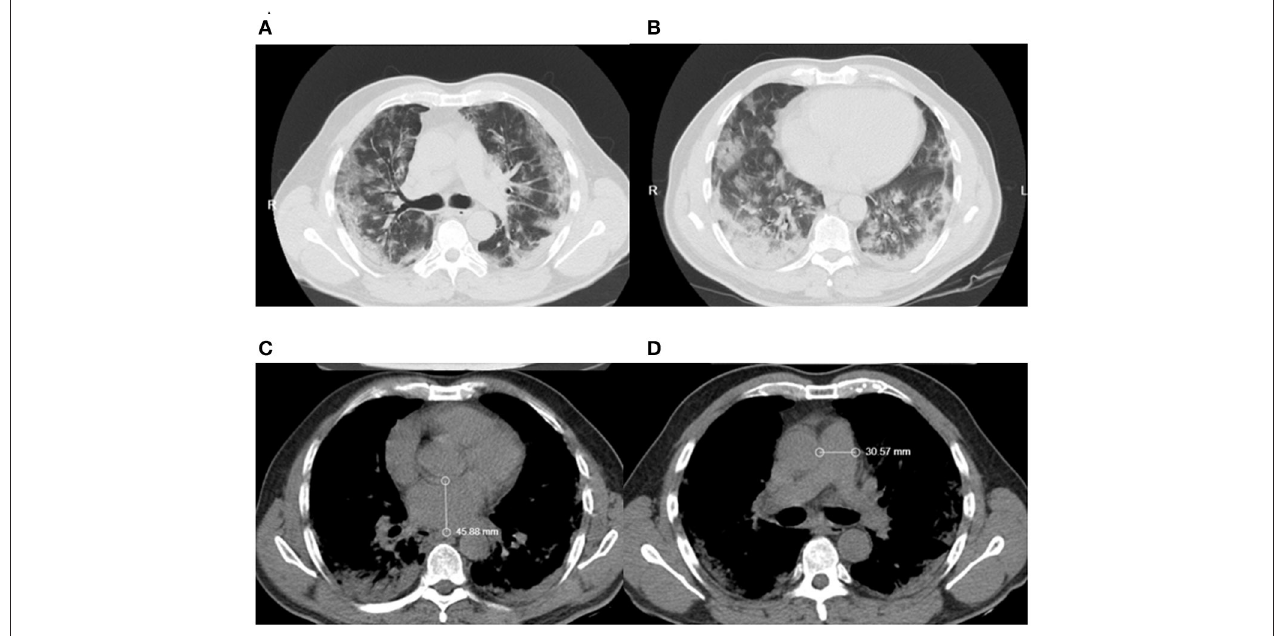
FIGURE 2 | Patients chest CT showing (A) vascular enhancement sign (B) ground-glass opacities (C) left atrium diameter (D) pulmonary artery trunk